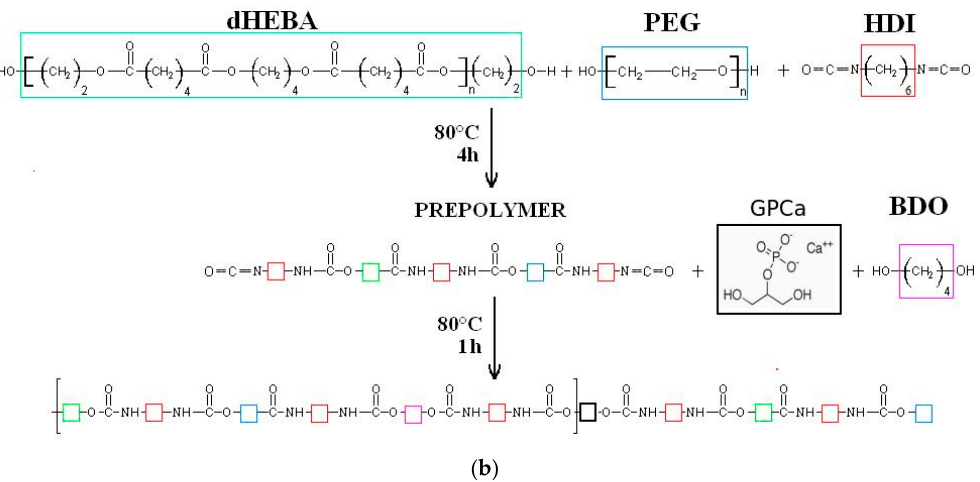
Figure 1. Synthesis of unmodified ( a ) and calcium glycerolphosphate (GPCa)-modified ( b ) poly(ester ether urethane)s (PEEURs).